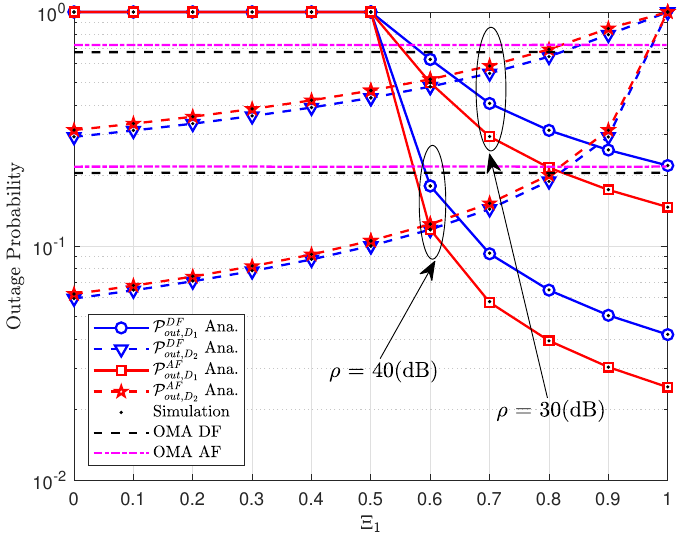
Figure 3. The outage probability versus the power allocation coefficients Ξ 1